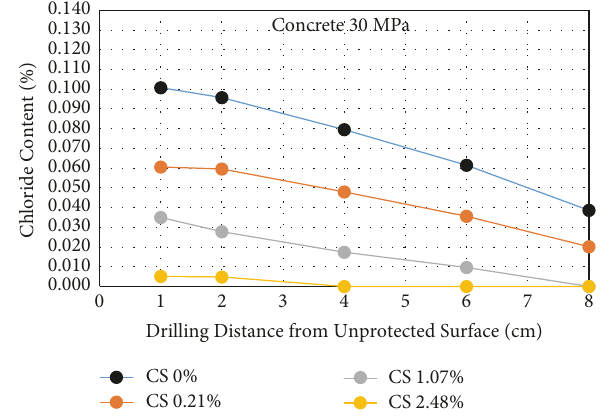
Figure 11: Chloride content in 30 MPa concrete.